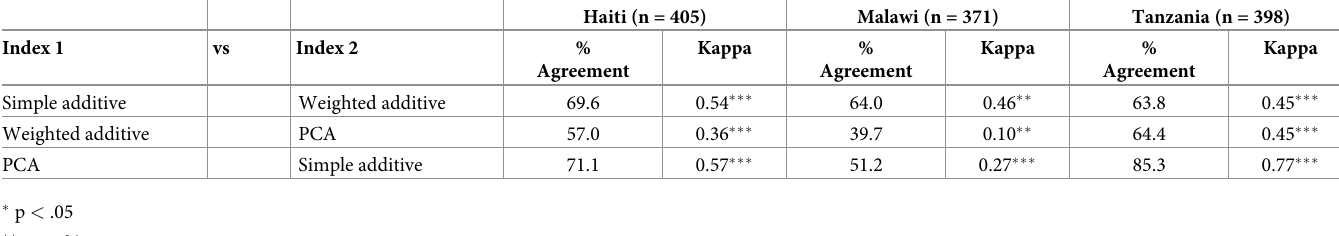
Table 5. Percent agreement and Cohen’s kappa coefficient among three quality of care scores among health facilities providing family planning services in Haiti, Malawi, and Tanzania.